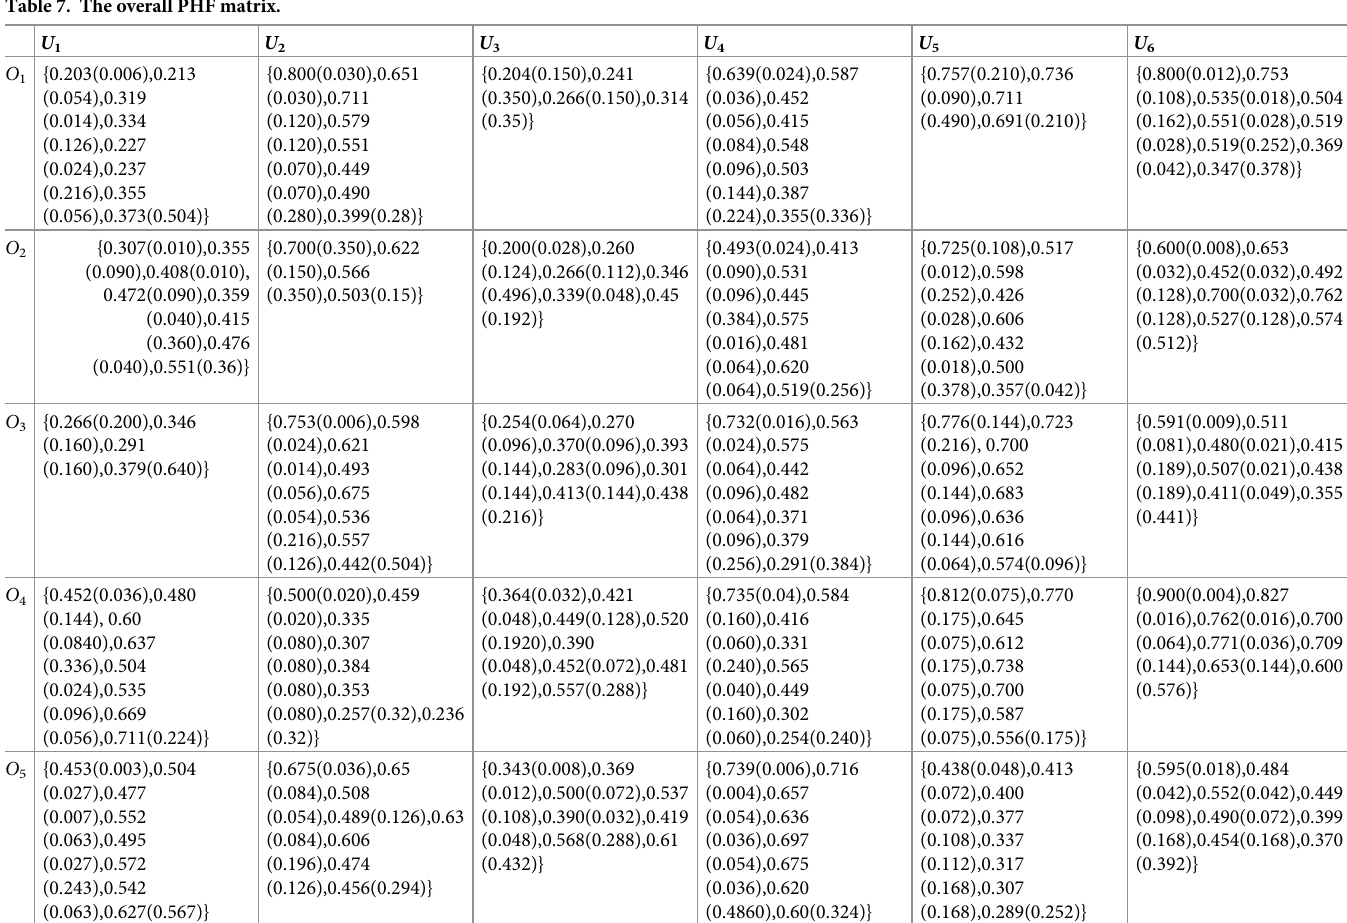
Table 7. The overall PHF matrix.